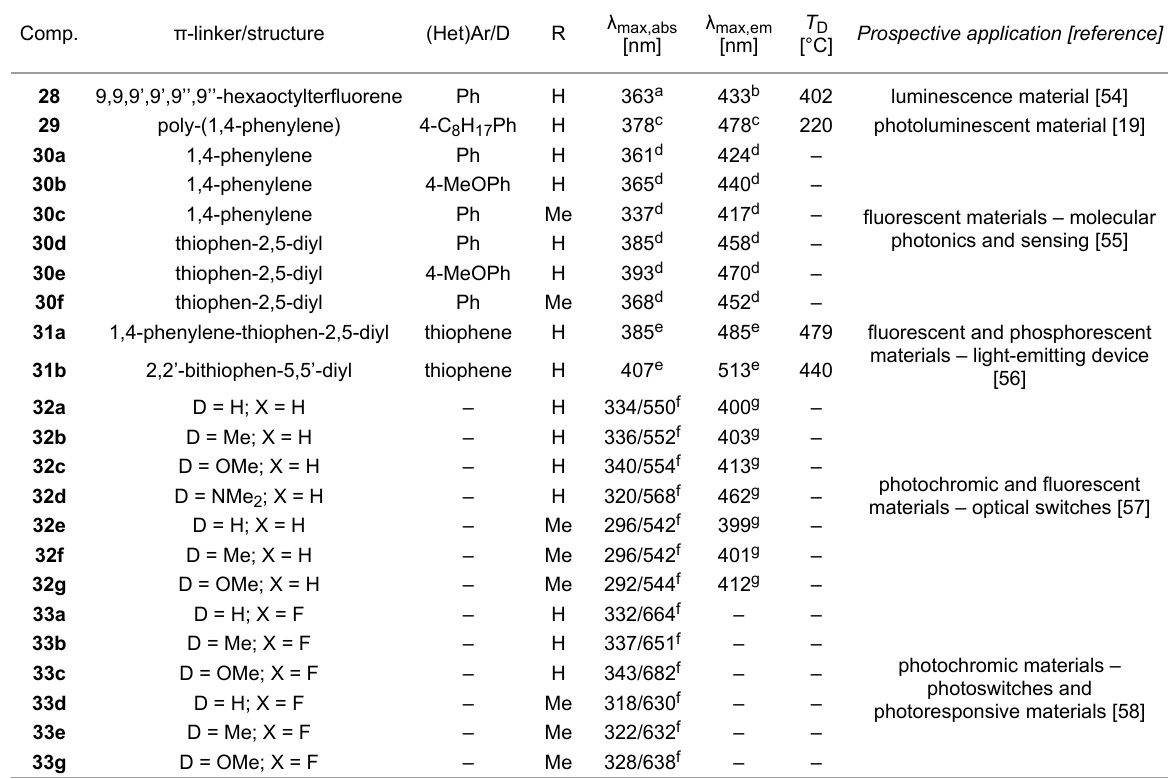
Table 6: Structure and selected properties of diimidazoles 28 – 33 [19,54-58].